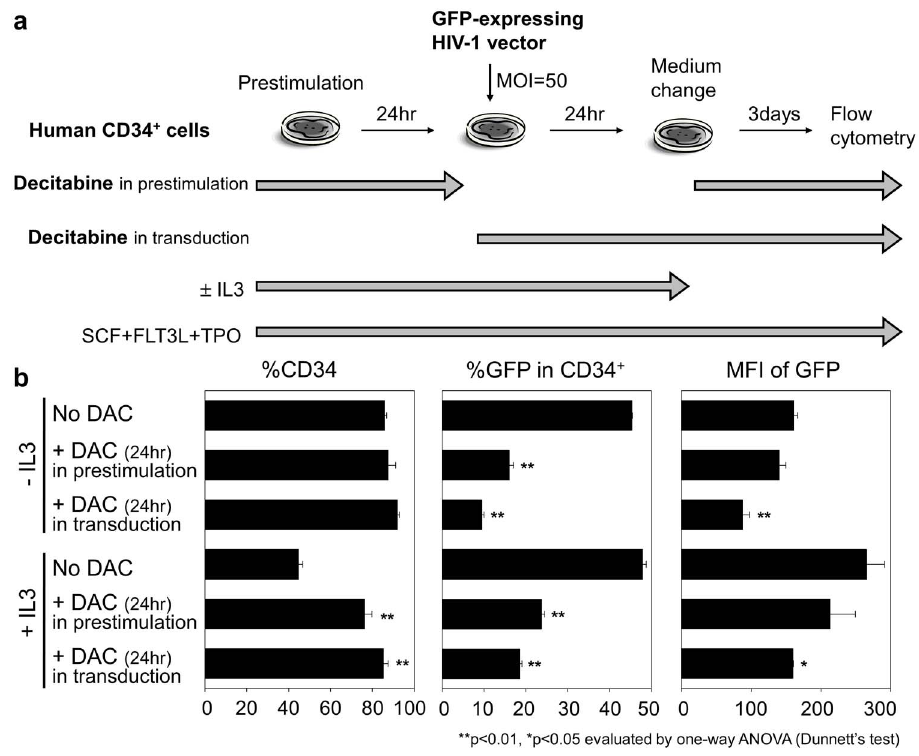
Figure 1. Decitabine reduced GFP-positive rates (%GFP) in transduced human CD34 + cells. (a). Human CD34 + cells were cultured in serum-free media containing cytokines (SCF, FLT3L, and TPO). After 24 hours of prestimulation, the cells were transduced with GFP-expressing HIV-1 based lentiviral vectors for 24 hours. Decitabine (0.5 m M) was added into media during either prestimulation (24 hours) or transduction (24 hours). After transduction, media were changed to fresh media containing cytokines and decitabine, and 3 days later, both CD34 expression and GFP expression were evaluated by flow cytometry. In addition, we investigated supplement of IL3 into media during prestimulation and transduction. (b). The %GFP in CD34 + cells was decreased by decitabine exposure in both prestimulation and transduction. Decitabine treatment led to higher CD34- positive rates (%CD34) when IL3 was added. We tested statistical significance of data in both decitabine exposure groups, compared to no decitabine exposure. DAC: decitabine, SCF: stem cell factor, FLT3L: fms-like tyrosine kinase 3 ligand, TPO: thrombopoietin, IL3: interleukin-3, MFI: mean fluorescence intensity, and MOI: multiplicity of infection.